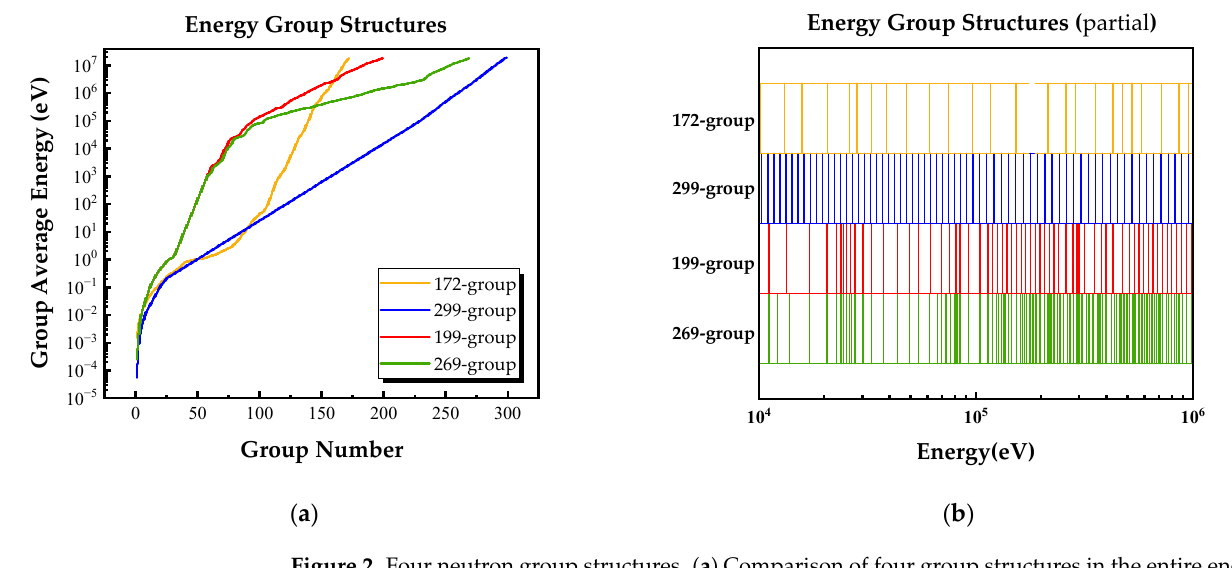
Figure 2. Four neutron group structures. ( a ) Comparison of four group structures in the entire en- ergy range. ( b ) Comparison of four group structures between 10.0 keV and 1.0 MeV in which sig- ni fi cant resonances